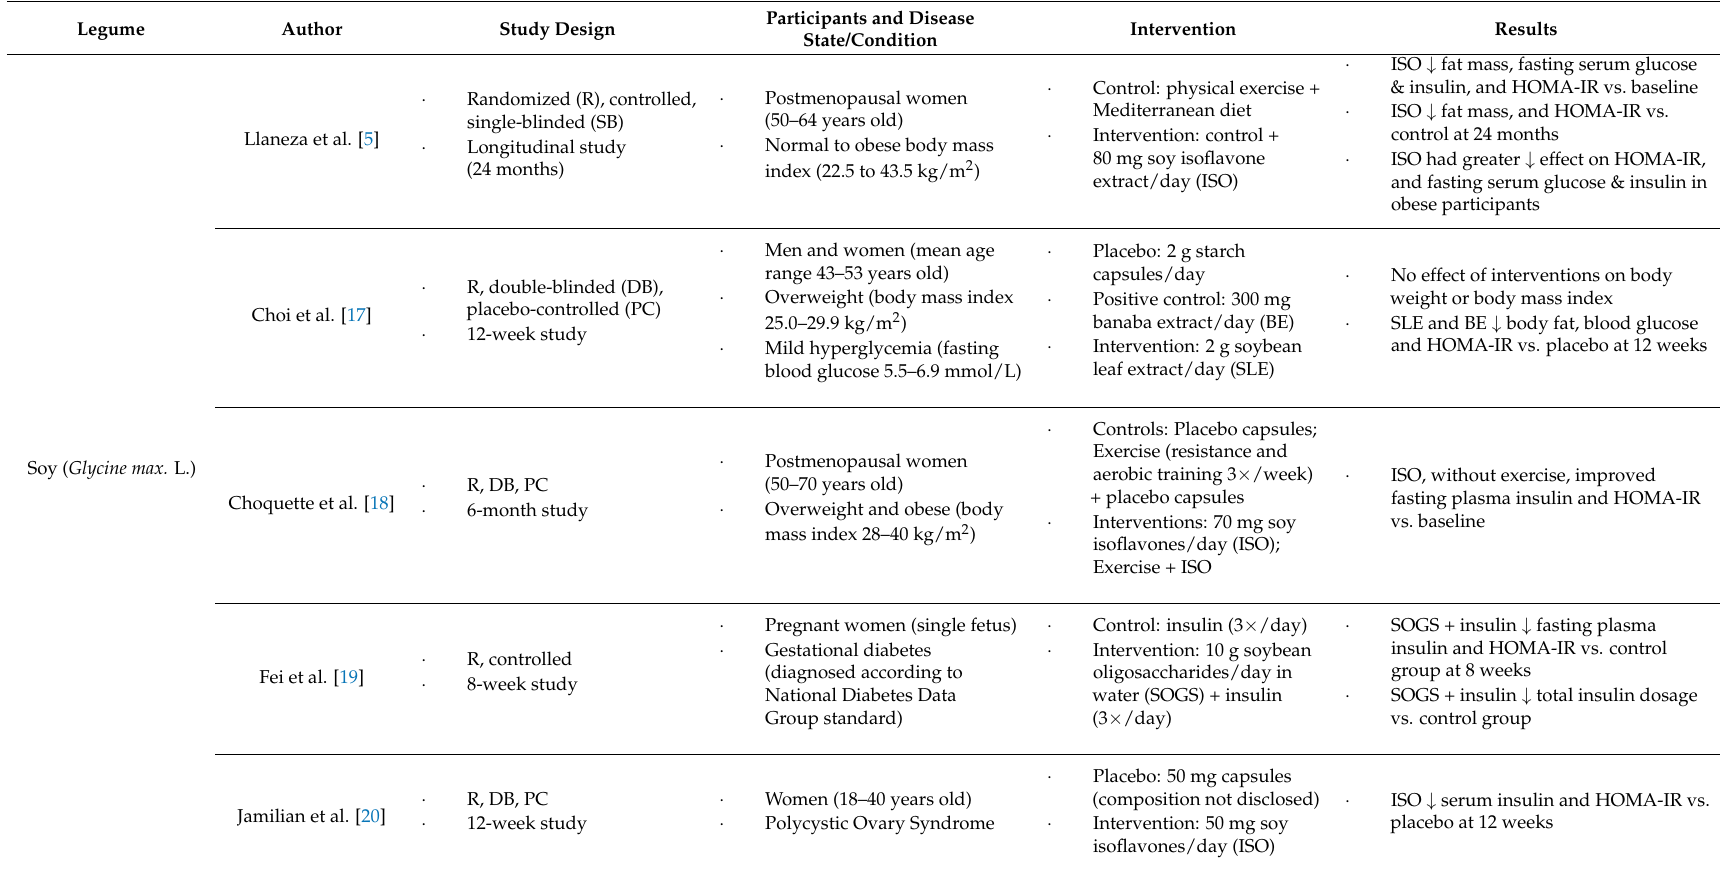
Table 1. Clinical trials investigating the efficacy of soybeans and pulses to improve insulin